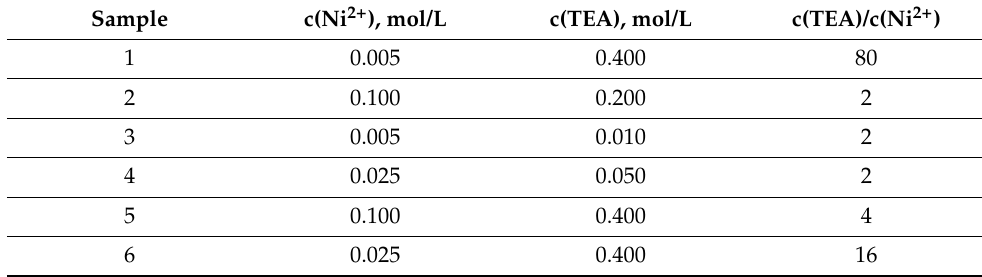
Table 1. Designation of samples and reagent concentrations in the corresponding reaction